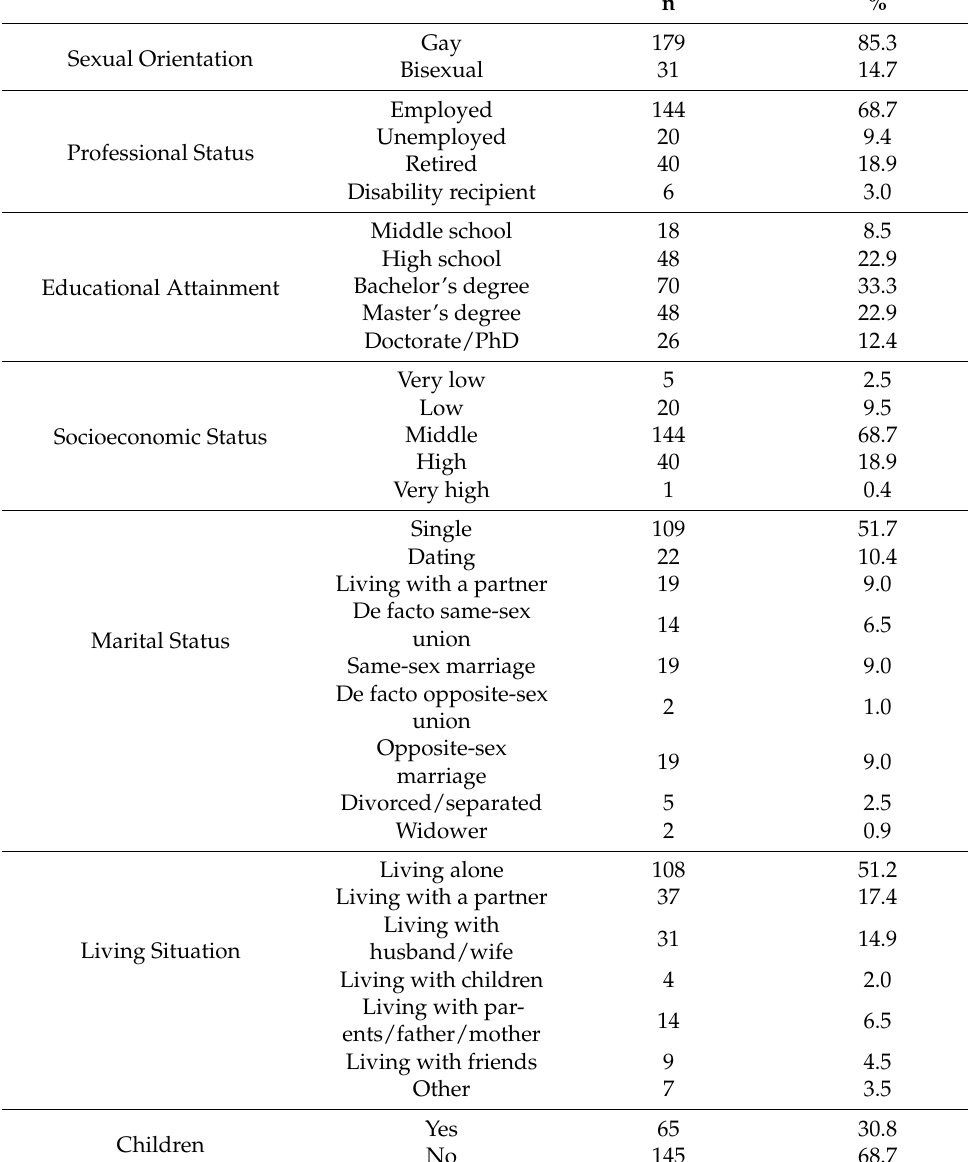
Table 1. Sociodemographic characteristics (M age = 58.85; SD =